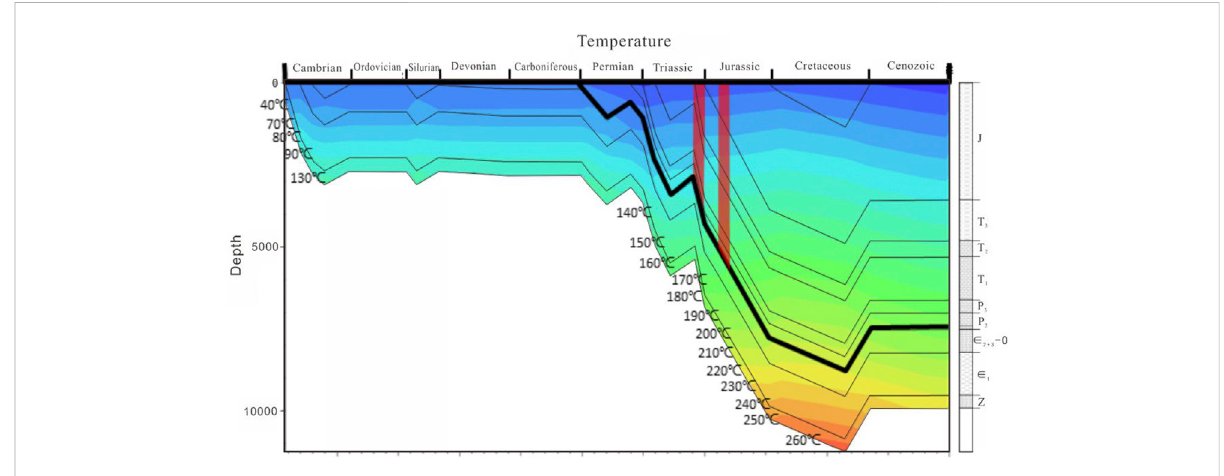
FIGURE 10 Burial and thermal history of the Northwestern Sichuan Basin to show the hydrocarbon charging stage and time.